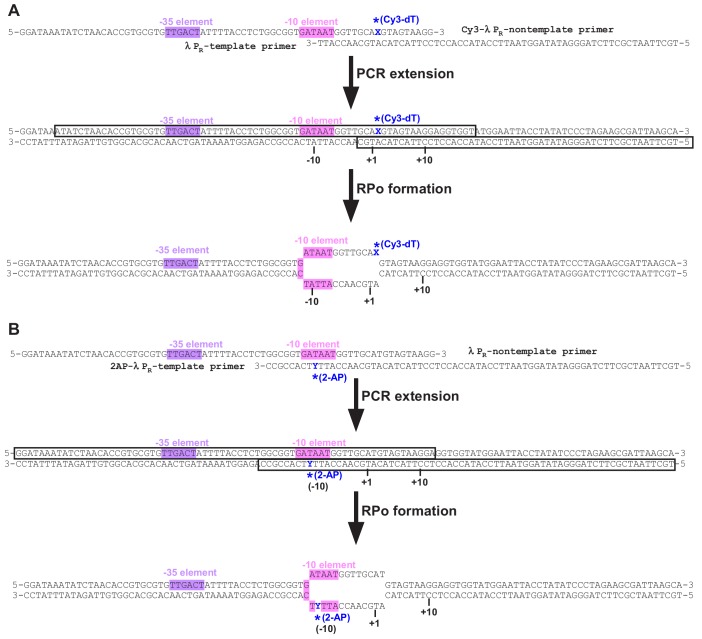
The promoter DNA used for stopped-flow fluorescence experiments.